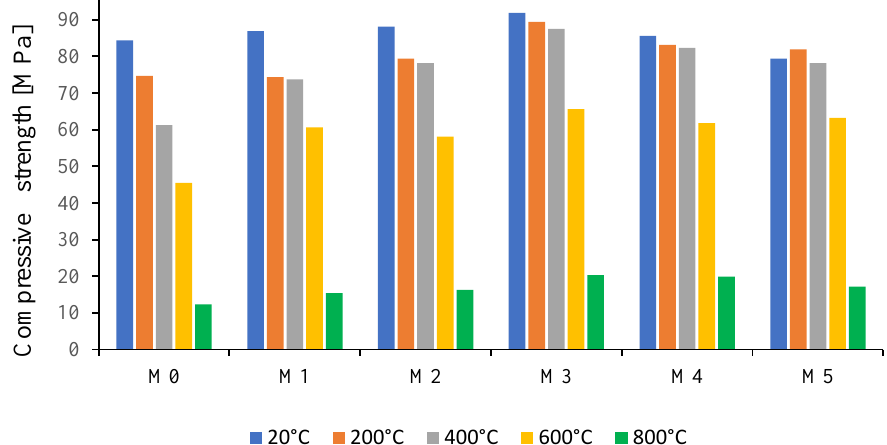
Figure 3. Compressive strength of the mortars after heating and curing for the next 24 months.